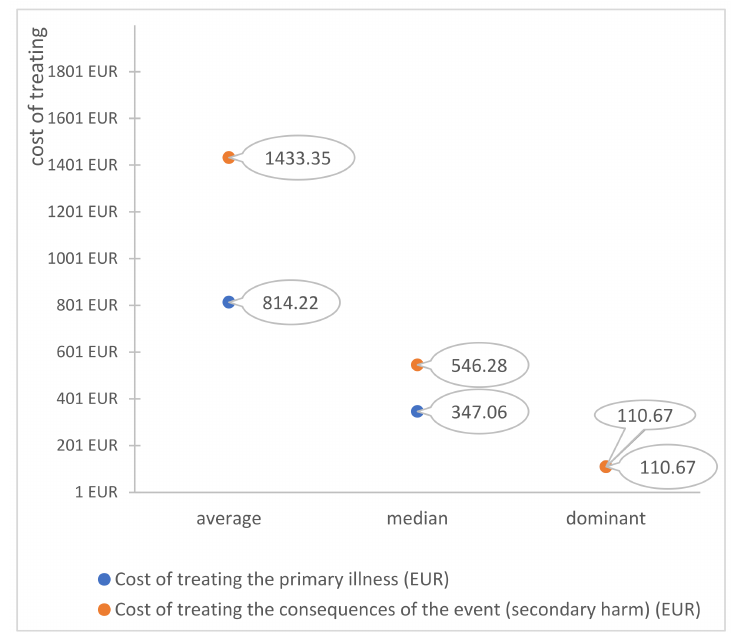
Figure 6. Cost of treating the primary illness and the consequences of the event